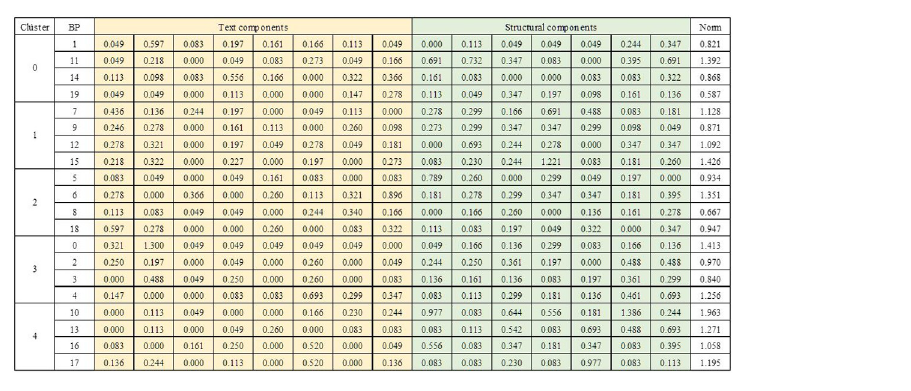
Fig 7. BPs organized by cluster using the ICA.